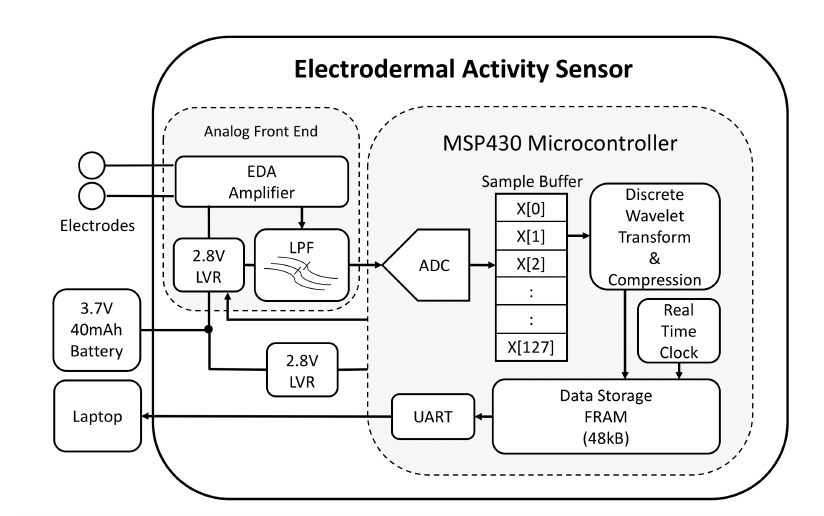
Figure 3. System diagram of developed electrodermal activity sensor. ADC = analog-to-digital converter, EDA = electrodermal activity, LPF = low pass filter, LVR = linear voltage regulator, FRAM = ferroelectric random access memory, UART = universal asynchronous receiver-transmitter serial communication protocol, X = skin conductance